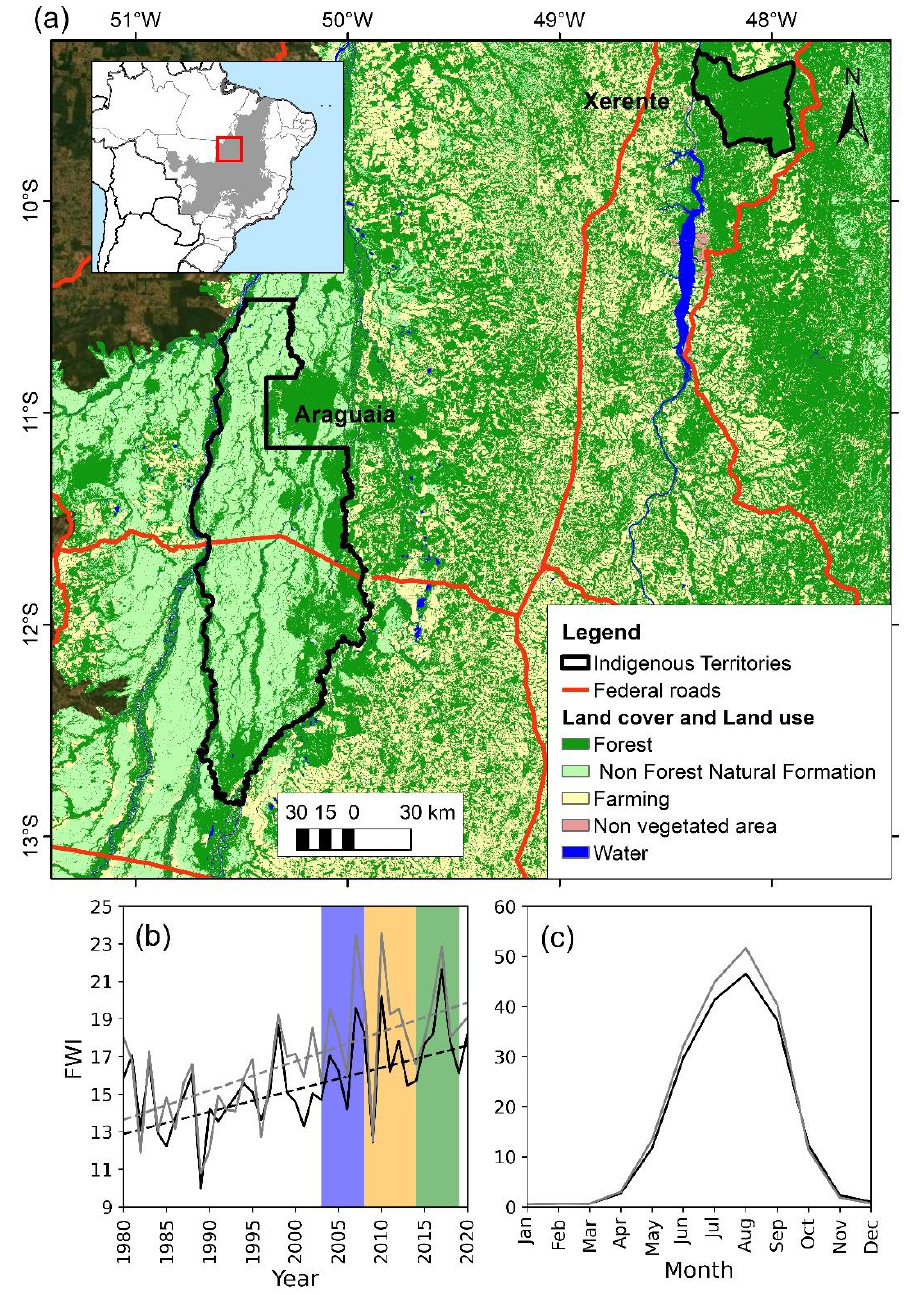
Figure 1. ( a ) Study area location: Xerente and Araguaia ITs, located in the Northern Cerrado (grey in the small panel) over Brazil. Land cover and land use information are derived from the MapBiomas Collection 5 [44] dataset and shown for 2019. ( b ) Fire Weather Index (FWI) annual values from 1980 to 2020 for Xerente (black) and Araguaia (grey). Dashed lines represent the trendline obtained using nonparametric Theil–Sen Robust Linear Regression (TS) and a two-tailed Mann–Kendall (MK) test of significance. NFP, ZFP, and IFMP are highlighted in blue, yellow and green, respectively. ( c ) FWI intra-annual variability for Xerente (black) and Araguaia